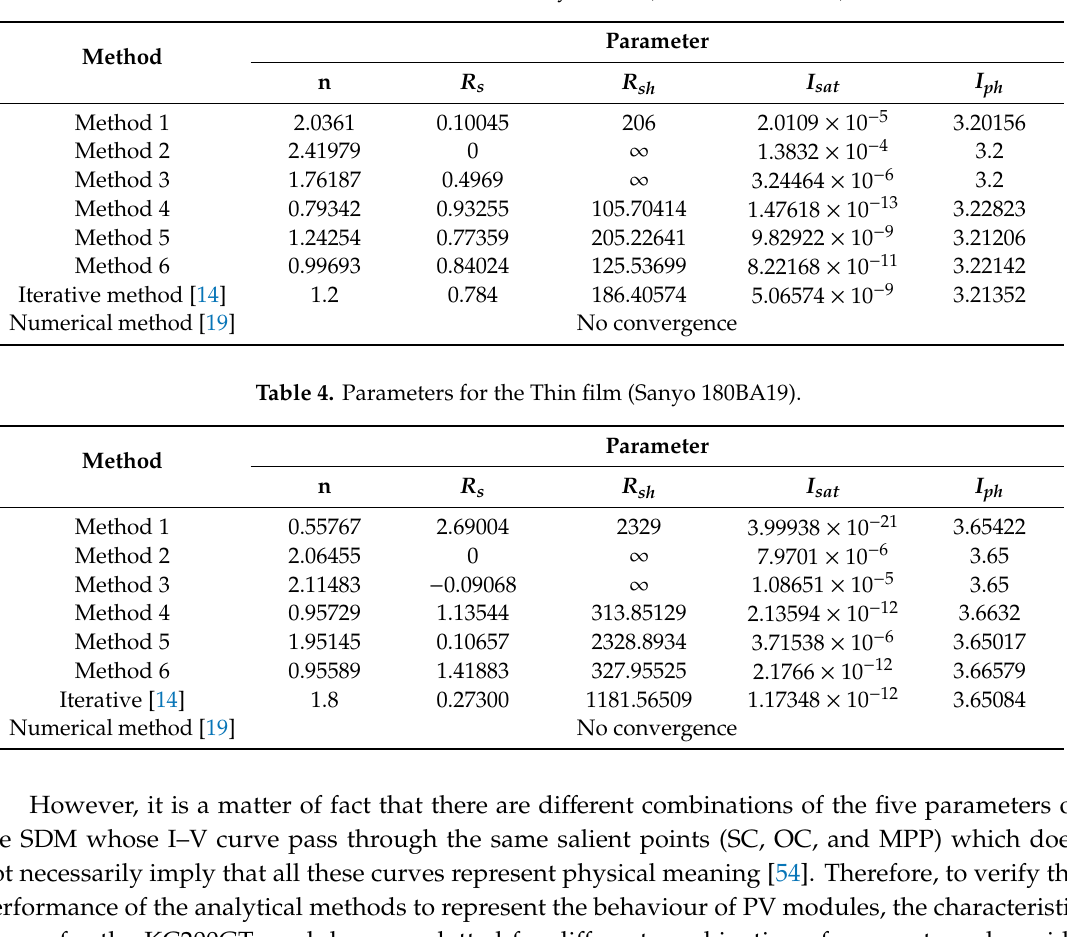
Table 3. Parameters for the Monocrystalline (Lorentz LC50-12M).